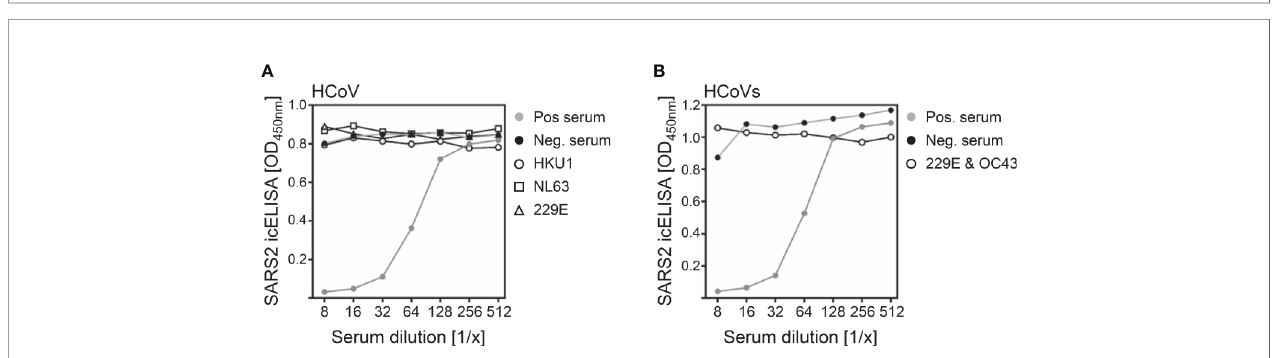
FIGURE 5 | The icNT provides superior resolution upon usage of increased virus doses. (A – F) 200 or 8,000 PFU of SARS-CoV-2 were incubated with indicated dilutions of serum samples for 1 h before Vero E6 cells were infected. At 20 and 16 h p.i. (for 200 and 8,000 PFU, respectively), neutralizing capacity was evaluated by icELISA. Samples measured on the same plate are depicted in one diagram. The control serum was used as reference for all plates. Please note the different y- axis scales of the left and the right panel.